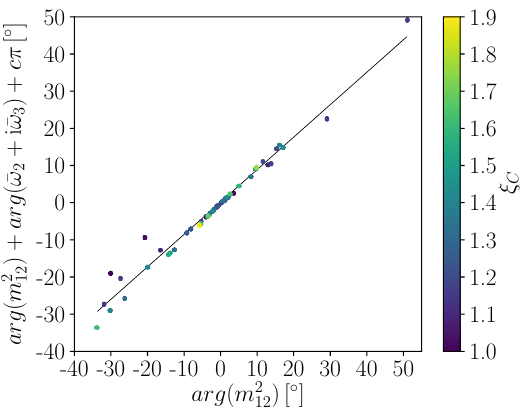
(cid:22) ! 1 j j (cid:22) ! 3 , and (cid:22) ! 3 = (cid:22) ! 2 . j j